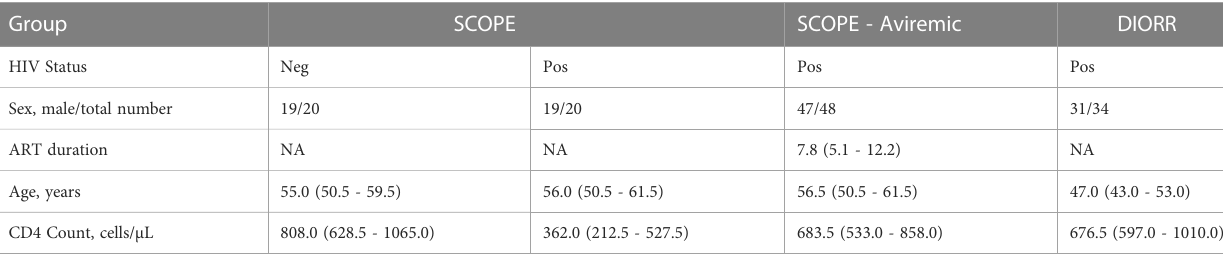
TABLE 1 Clinical characteristics of